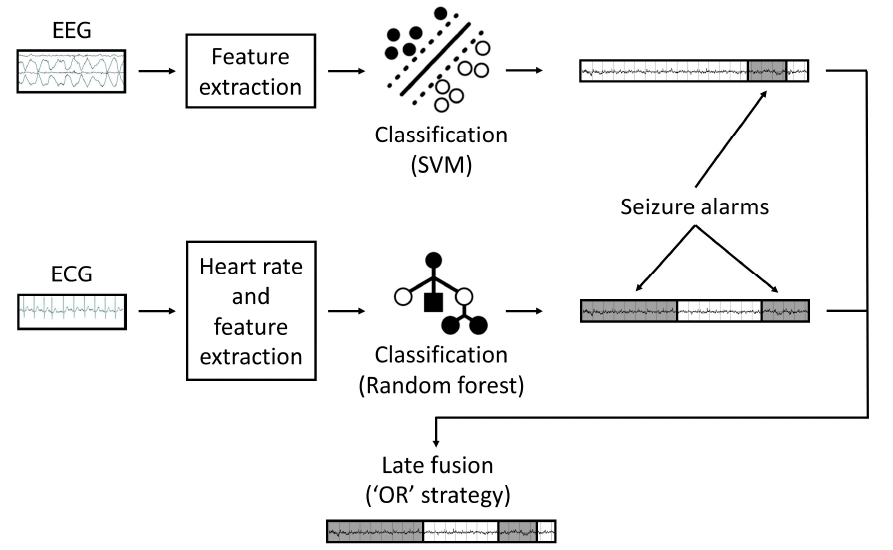
Figure 1. Graphical representation of the multimodal automated multimodal seizure detection framework based on bte-EEG and ECG.